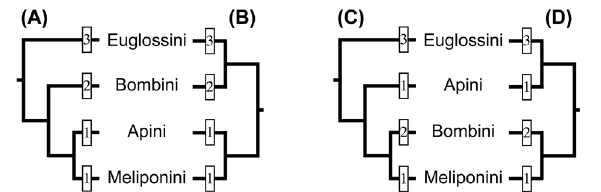
Fig 3. Schematic representation of four commonly proposed hypotheses of phylogenetic relationships among the four tribes of corbiculate bees (Apidae). Hypotheses A and B are favored by the several datasets comprising phenotipical characters (Fig 2: hypothesis H2-e and H2- c), whereas Hypotheses C and D are recurrent results when these relationships are inferred using molecular datasets (Fig 2: hypothesis H1-e and H1-c). Numbers at each of the terminal branches represent conditions of sociality: 1 : fixed-caste eusociality; 2 : totipotent-caste eusociality; 3 : social behaviors present, but not eusociality. Tree topologies A-C correspond to hypotheses H2-e, H2-c, H1-e, H1-c (Fig. 2),